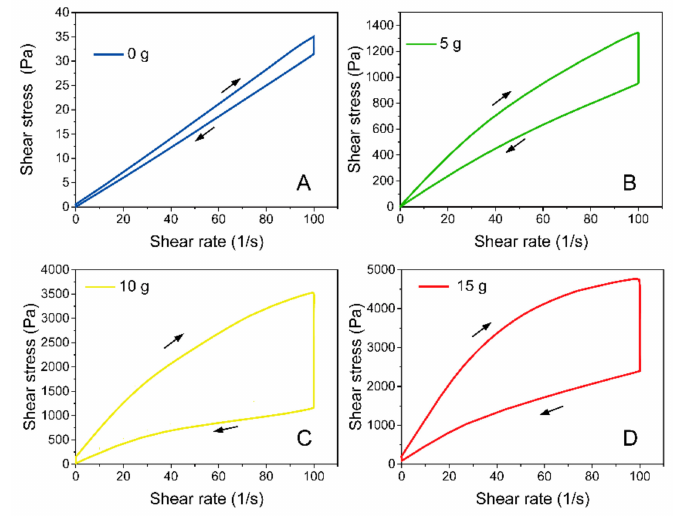
Figure 1. Flow curves of AAM coating with increasing CMS content. (A) plain AAM, (B) AAM composited with 5 g CMS, (C) AAM composited with 10 g CMS, (D) AAM composited with 15 g